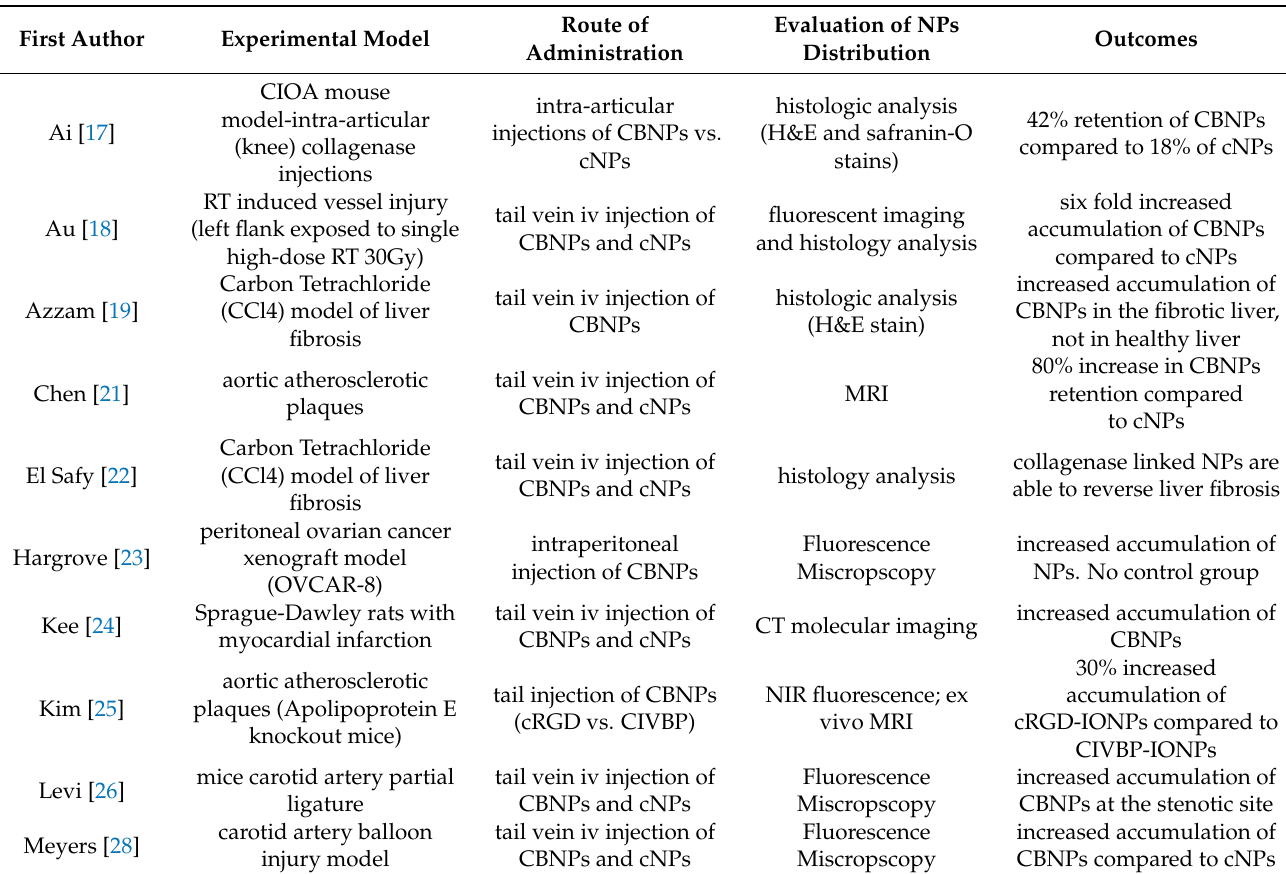
Table 4. In vivo